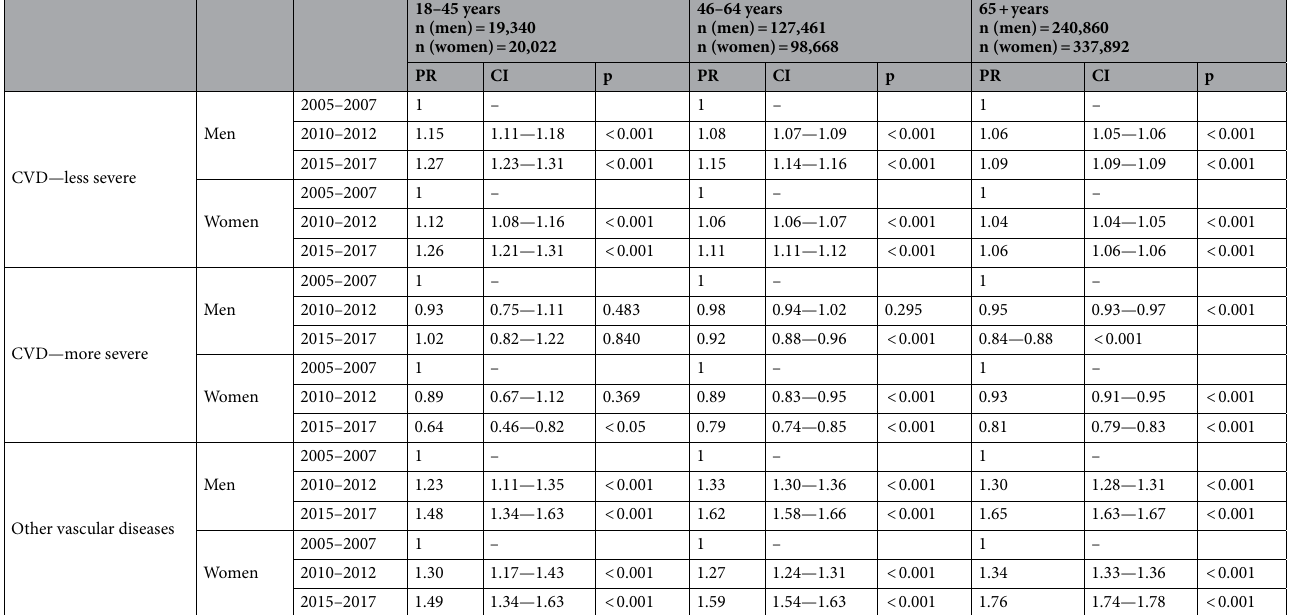
Table 4. Prevalence ratios and confidence intervals of the effect of time period on the comorbidity-index variables (1) severe CVD, (2) less severe CVD and (3) other vascular diseases, stratified by age and gender as estimated by means of logistic regression adjusting for within cluster variation. Adjusted for age (within each age group) and insurance duration. CVD-less severe: hypertension, cardiac insufficiency or hyperlipidemia. CVD-more severe: stroke, myocardial infarction or angina pectoris. Other vascular diseases: retinopathy, nephropathy or polyneuropathy.